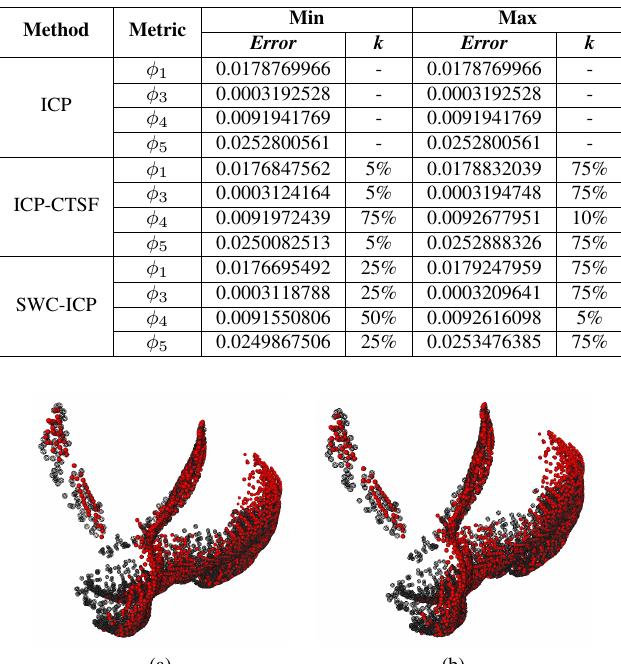
TABLE II: Performance of ICP, ICP-CTSF and SWC-ICP for 45 ◦ . alignment 0 ◦ −